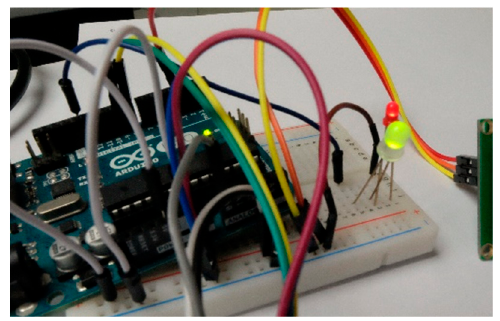
Figure 15. LED turned on. Figure 16. LCD showing the